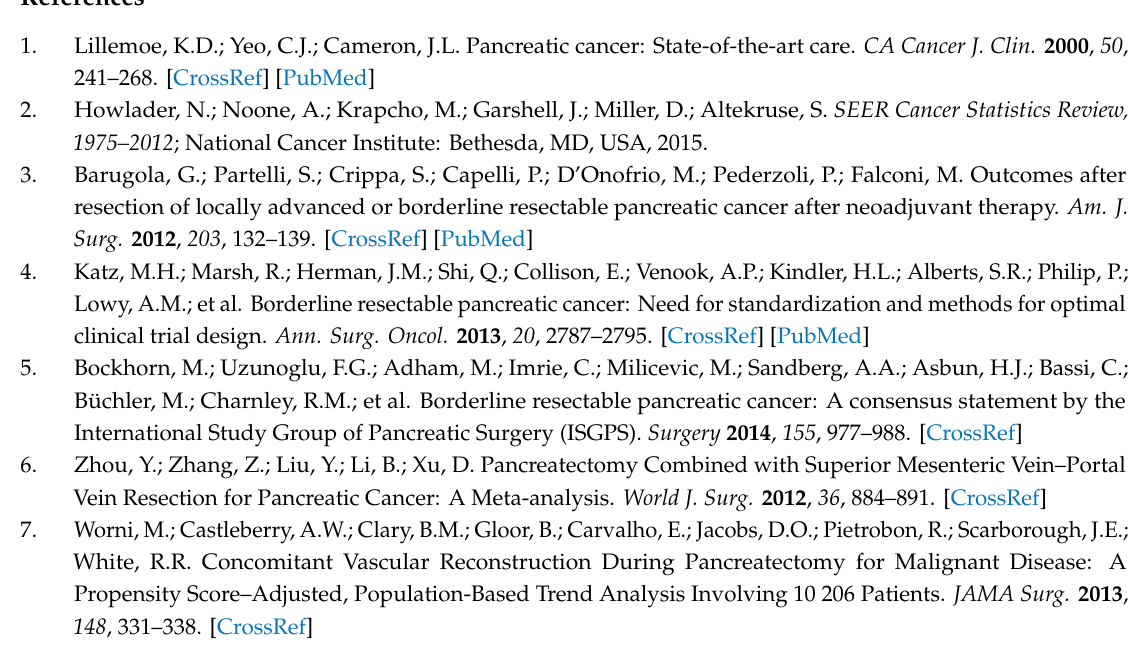
Table S1: STARD 2015 List of Study